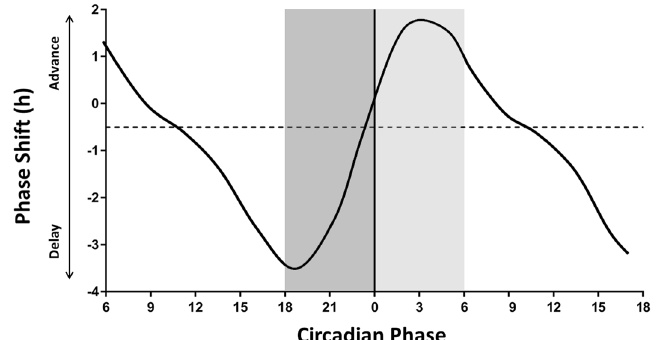
Figure 2. Phase response curve for light. A reference phase response curve (based on 50 ) was used for determining phase in the regression model. Phase shifts are plotted (solid black line) against the circadian timing of light exposure. Positive values on the y-axis indicate a phase advance and negative values indicate a phase delay. Zero on the x-axis represents core body temperature minimum. For the current study, the dark grey bar indicates the “delay zone”, which encompasses the circadian time at which light will induce a maximal phase delay. The light grey bar represents the “advance zone”, and encompasses the time at which light will induce a maximal phase